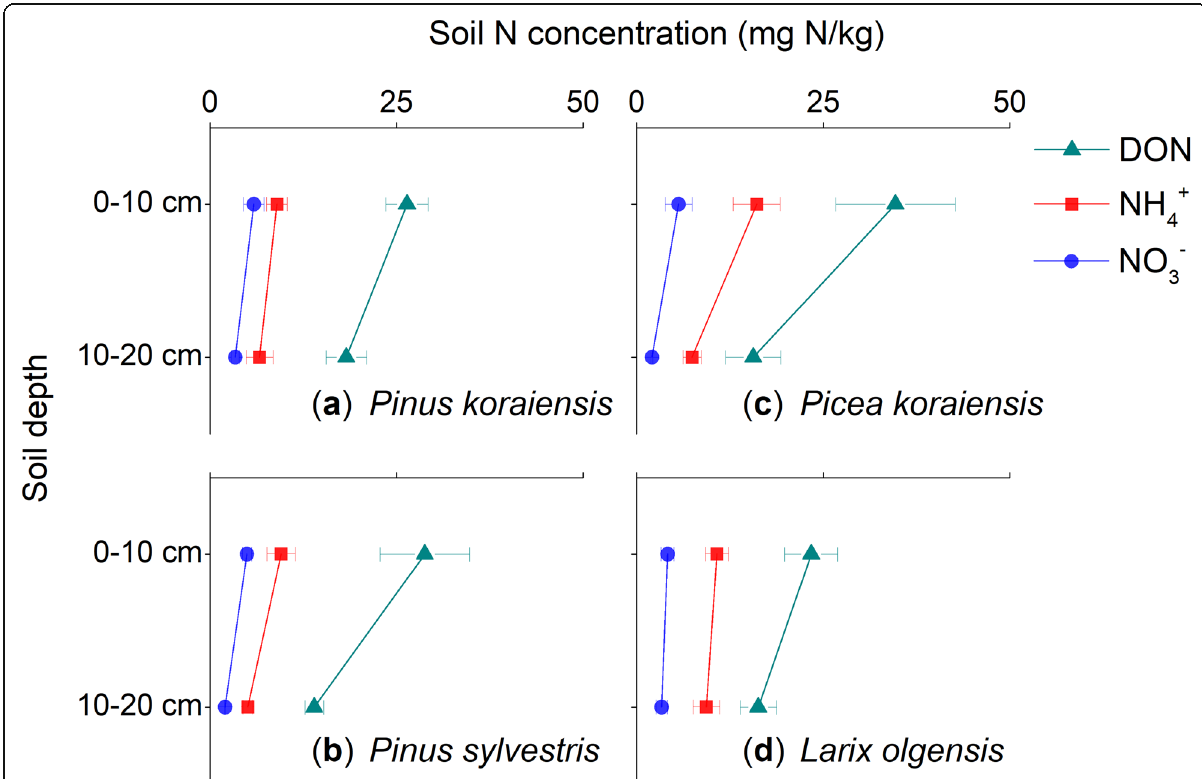
Fig. 1 Soil N concentration in the 0 – 10 cm and 10 – 20 cm mineral soil of the four studied forest plantations (means ± SE, n = 5). Concentration of ammonium and nitrate in mineral soil were reported in Zhou et al.